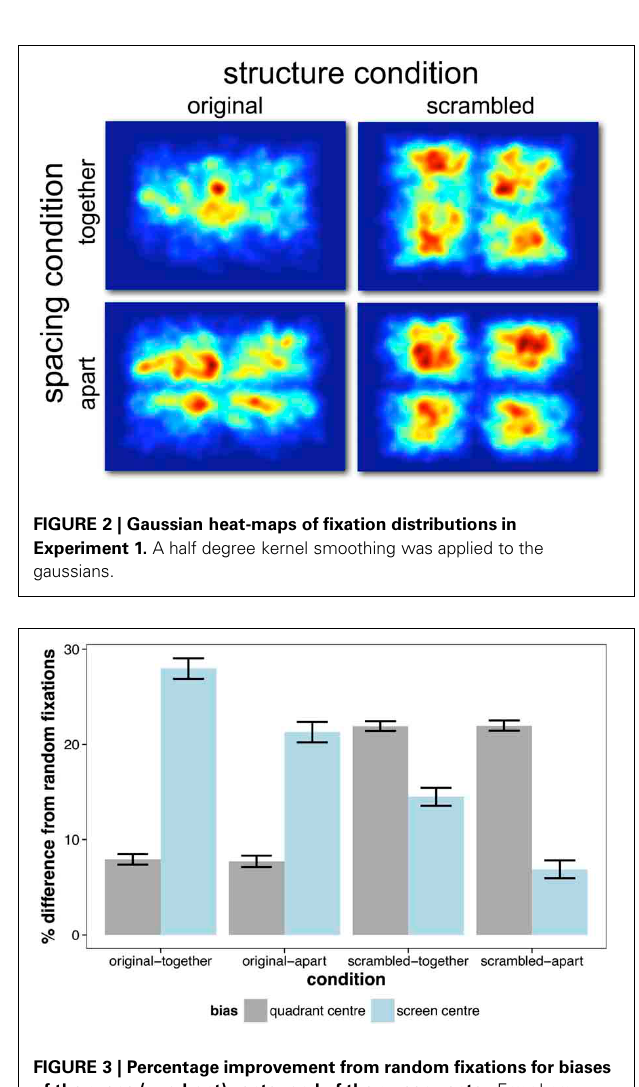
FIGURE 3 | Percentage improvement from random fixations for biases of the scene (quadrant) center and of the screen center. Error bars indicate ± 1 SE.